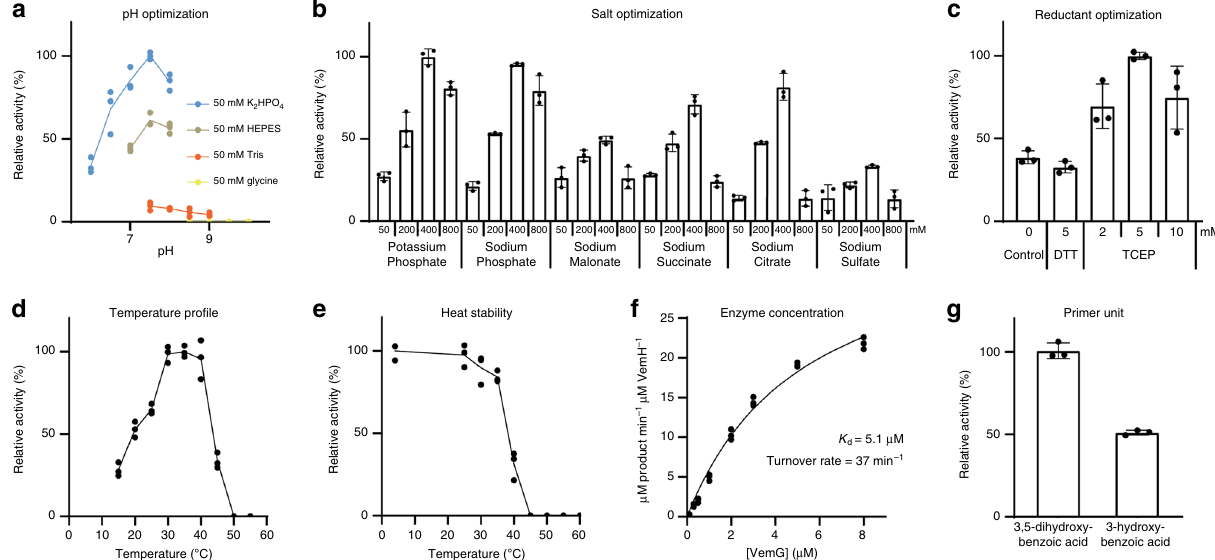
Fig. 2 In vitro reconstitution and reaction optimization of the venemycin assembly line. a The pH activity pro fi le indicates pH 7.5 is optimal. b In a salt screen, 400 mM potassium phosphate is best. c TCEP is better than DTT as a reductant. d Reactions are fastest at 30 – 35 °C. e However, the enzymes are not stable at these temperatures - activity after incubation of VemG and VemH at 4 – 55 °C for 30 min is shown. f Measuring activity at increasing concentrations of VemG (at constant 0.2 µ M VemH), enables the determination of the turnover rate and an apparent K d . g The assembly line accepts 3- hydroxybenzoic acid but is twofold slower. Data are mean ± s.d., n = 3 independent experiments. Source data are provided as a Source Data fi le.